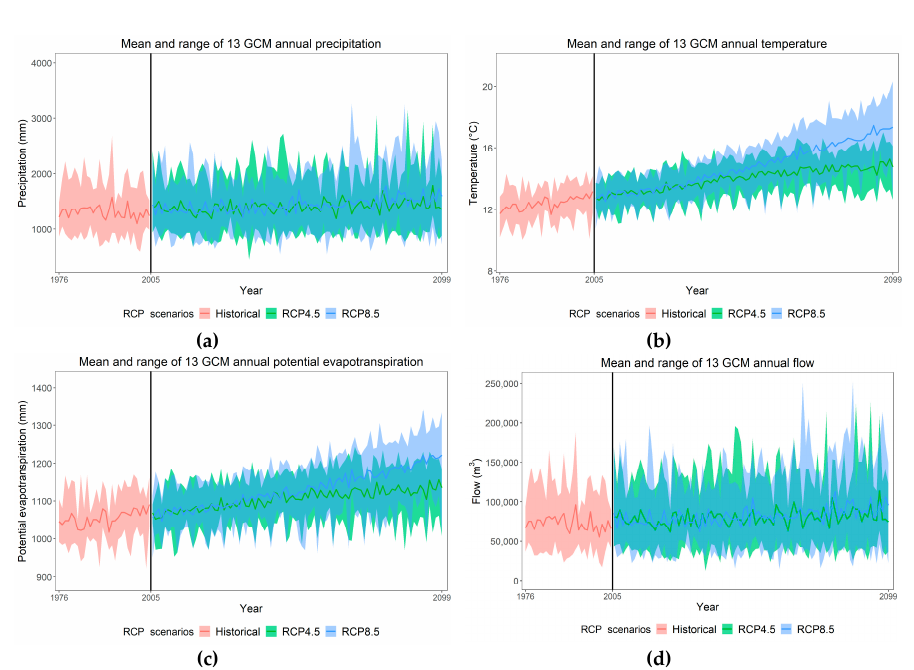
Figure 4. Annual ( a ) precipitation, ( b ) temperature, ( c ) potential evapotranspiration, and ( d ) flow during the reference (1976–2005) and future (2005–2099) periods for RCP scenarios 4.5 and 8.5 in South Korea. The values in this figure were calculated by converting daily data into annual data for 13 GCMs. The solid line denotes the average of 13 GCMs, and shaded areas denote the maximum and minimum values of 13 GCMs.